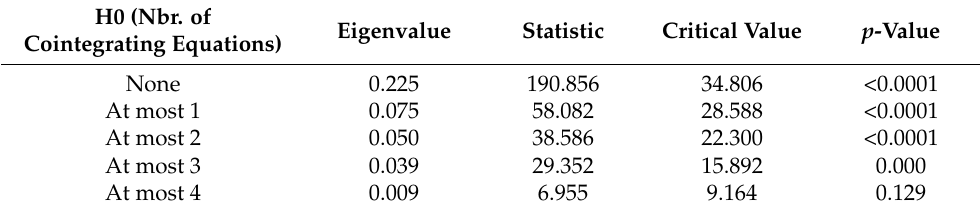
Table 3. Lambda max test, Johansen-Juselius procedure, authors source. H0 (Nbr.